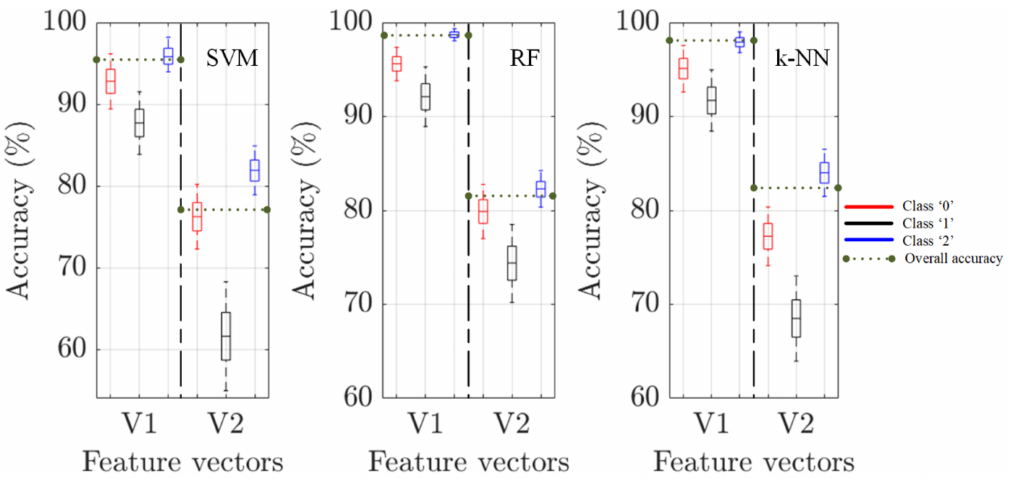
Figure 6. The accuracy scores of the developed feature vectors for the three ML classifiers.